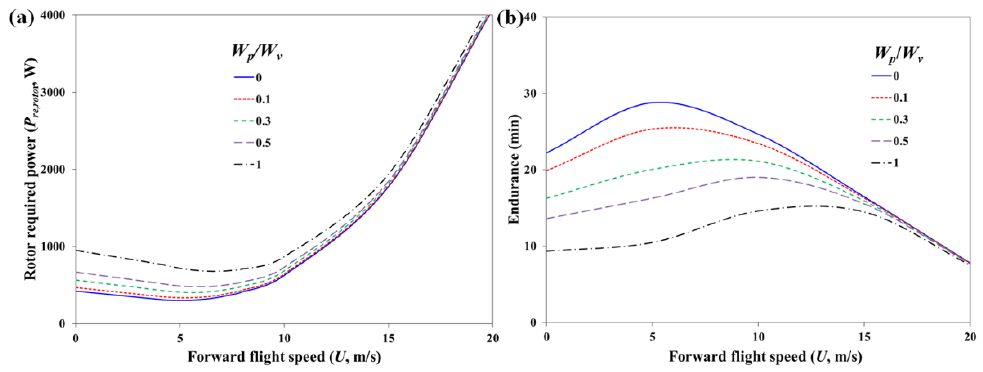
Figure 8. ( a ) Rotor required power; ( b ) estimated endurance with various payload weights.